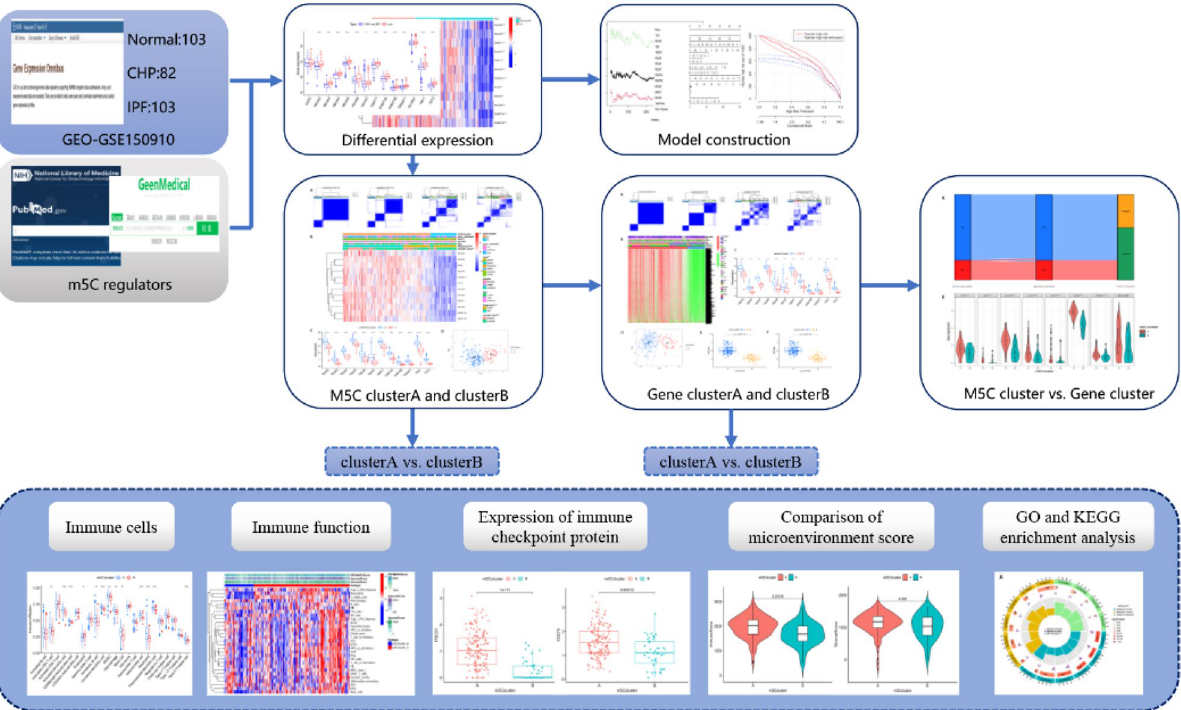
Figure 1. Flowchart of this